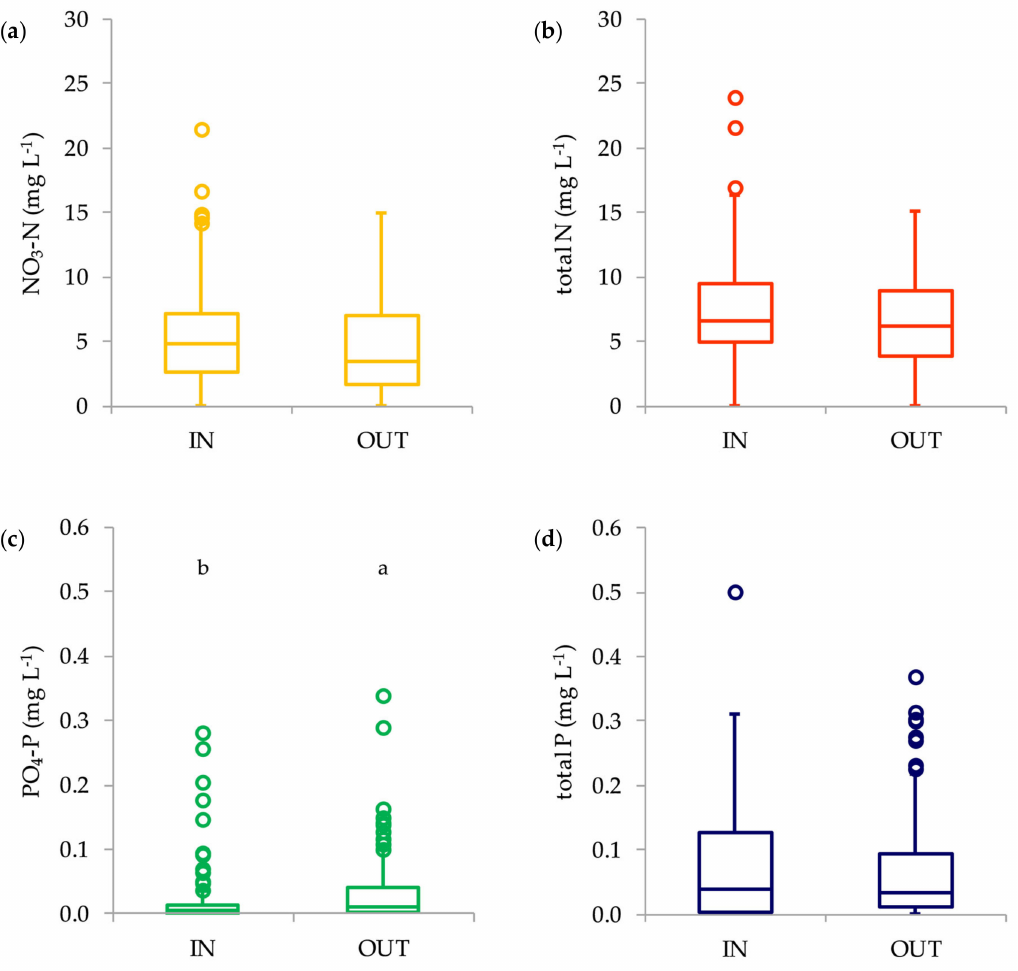
Figure 6. Nutrient inflow (IN) and outflow (OUT) concentrations of the entire period (2007–2013). ( a ) NO 3 –N; ( b ) total N; ( c ) PO 4 –P; ( d ) total P. Di ff erent letters indicate a significant di ff erence detected by the Mann–Whitney